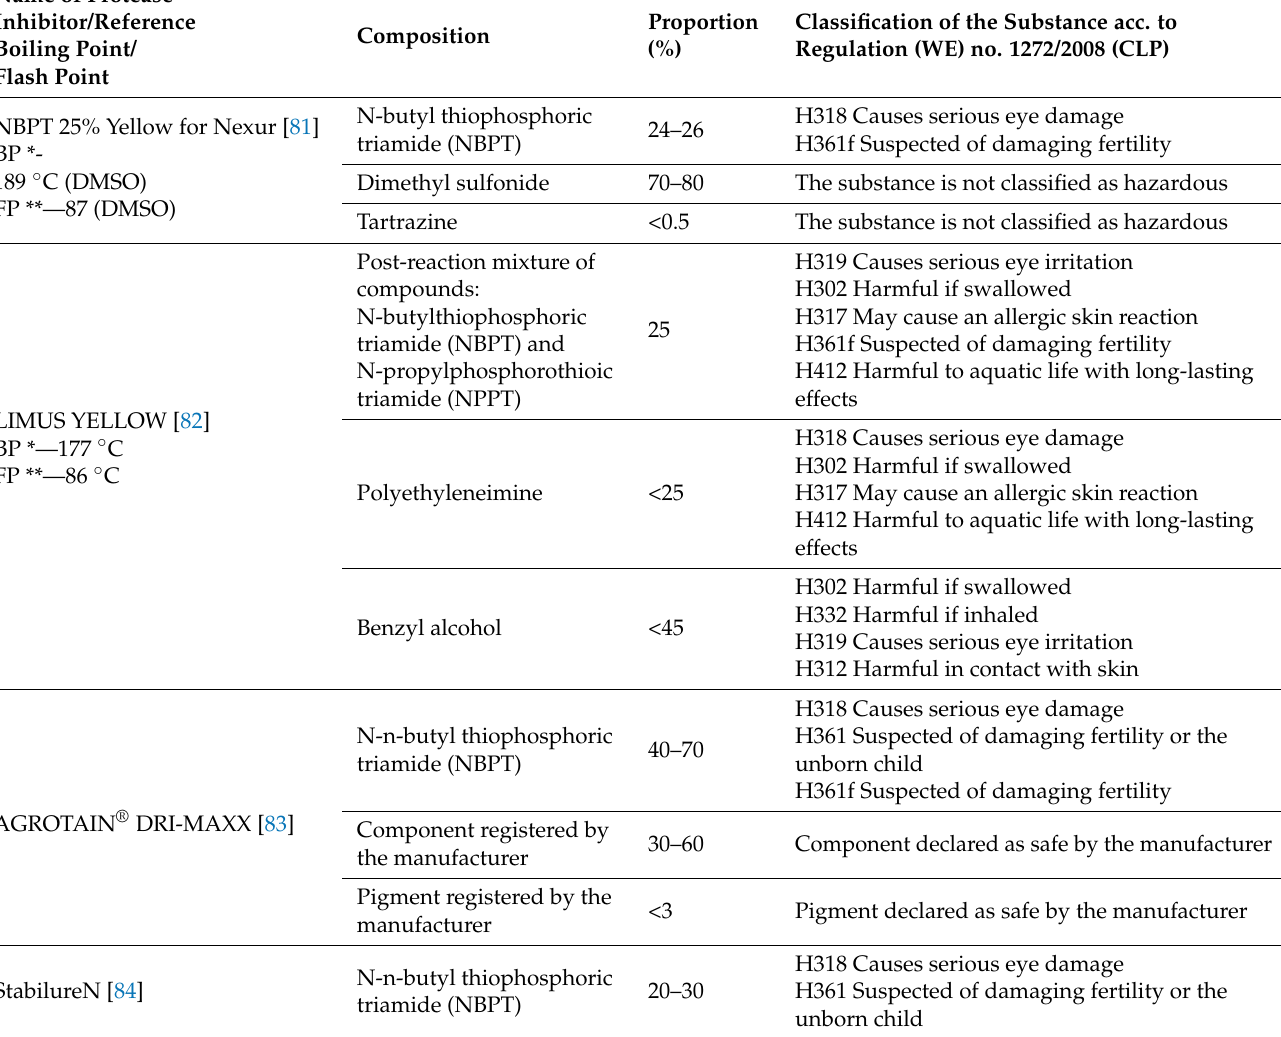
Table A1. Chemical composition and properties of urease inhibitors available on the market (composition and properties of formulations specified by manufacturers’